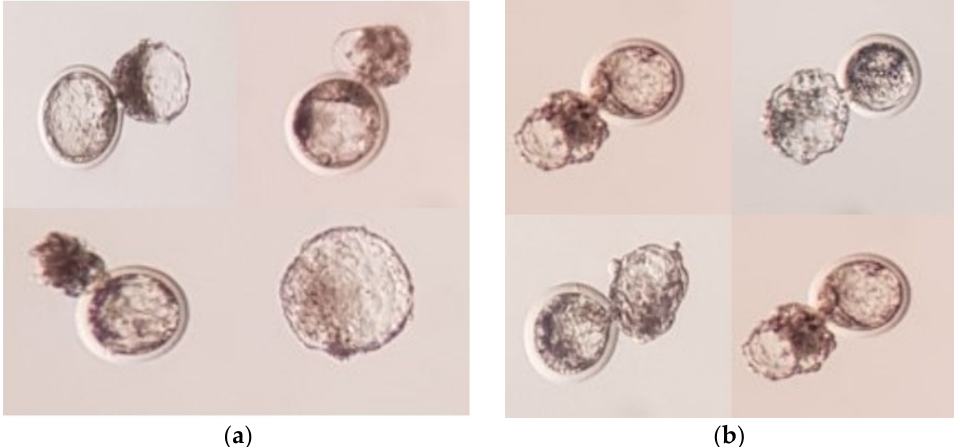
Figure 2. Representative photographs of blastocysts produced by SCNT using ( a ) in vitro matured oocytes ( b ) in vivo matured oocytes.